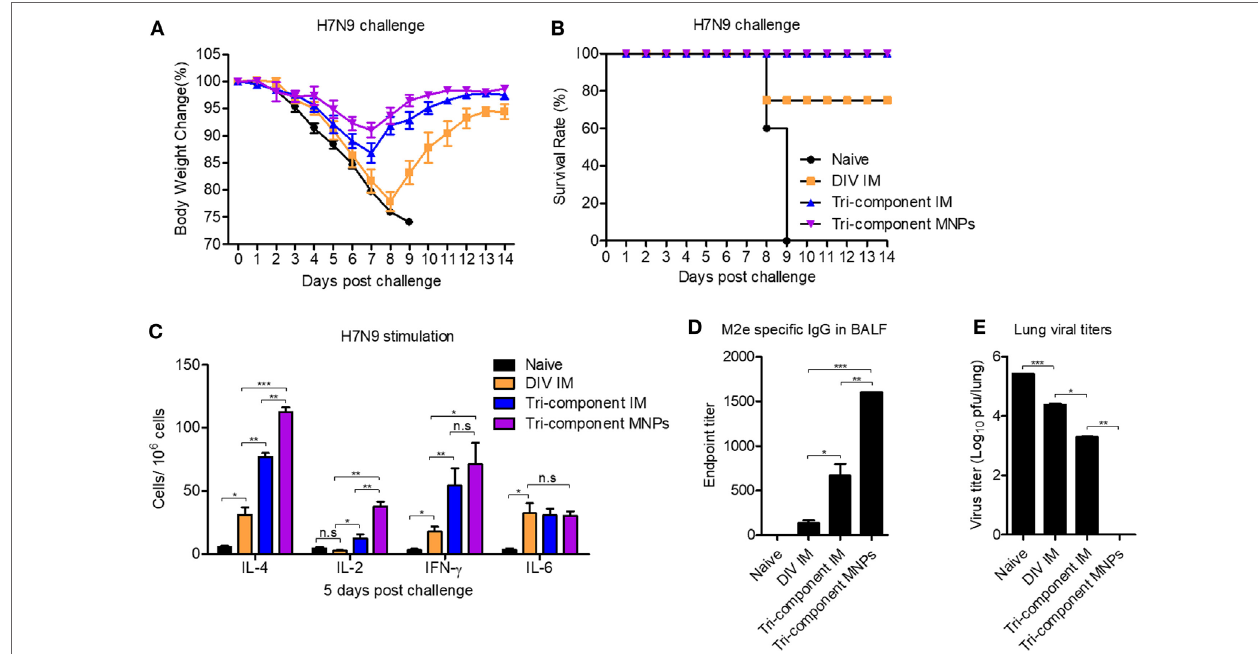
FigUre 5 | Protection efficacy against a heterologous influenza virus challenge. BALB/c mice ( N = 5) were intramuscular (IM) immunized with divalent inactivated vaccine (DIV), tri-component vaccine, or microneedle patch (MNP) immunized with the tri-component vaccine. Four weeks after the immunization, mice were challenged with 2 × LD 50 of A/Shanghai/02/2013 (H7N9, rSH) reassortant virus. Body weight changes (a) and survival rates (B) were monitored daily for 14 days. Mice were sacrificed at day 5 post challenge for the collection of spleens, bronchoalveolar lavage fluids (BALF), and lungs. (c) Cytokine-secreting cells in splenocytes were measured in the presence of 4 µg/ml purified A/Shanghai/02/2013 (H7N9, rSH) virus by ELISPOT. (D) The levels of M2e-specific IgG in BALF. (e) Lung viral titers. Data represent mean ± SEM. The statistical significance was analyzed by Student’s t -test. * p < 0.05, ** p < 0.01, *** p < 0.001, n.s p >